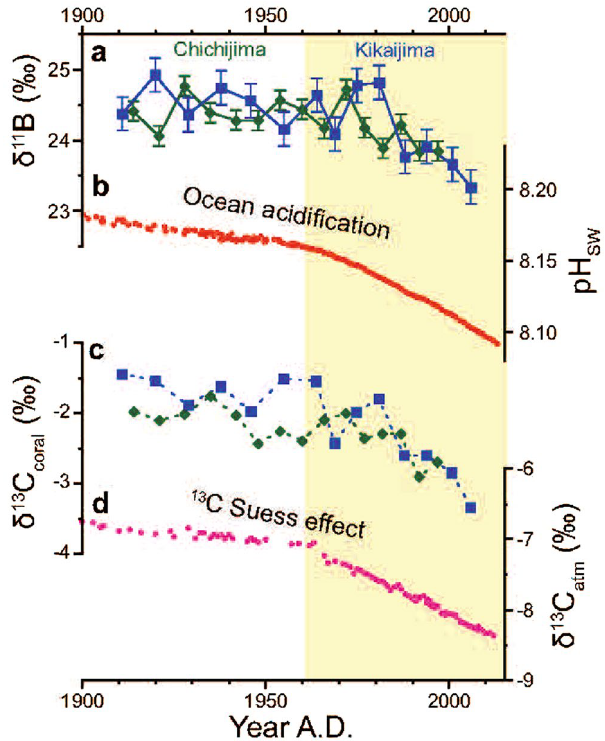
Figure 3. Coral δ 11 B and δ 13 C records, pH SW , and δ 13 C of atmospheric CO 2 . ( a ) δ 11 B records of the corals from Chichijima (green diamonds) and Kikaijima (blue squares). Each point is a 3-year average. Error bar is 2 σ of the analytical uncertainty of JCp-1. ( b ) As in Fig. 2d, but for years 1900–2013. ( c ) As in ( a ) but for δ 13 C coral